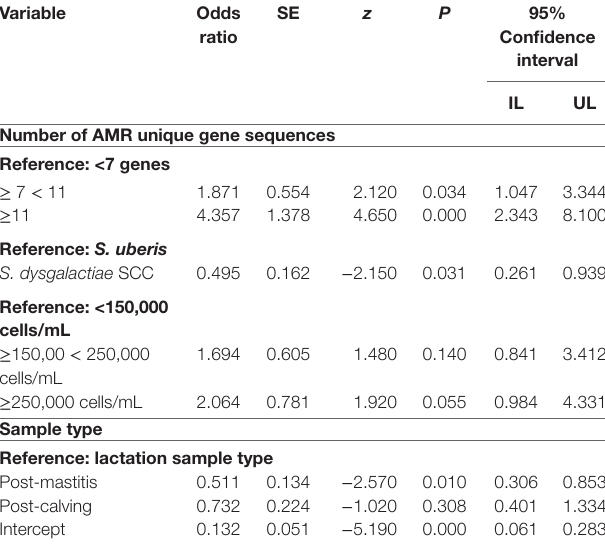
TaBle 4 | logistic model of aMr against 8 antimicrobials for isolates of Streptococcus uberis ( n = 56) and Streptococcus dysgalactiae ( n = 17) recovered from dairy cows on 17 farms in the Maritime provinces of canada (2007 and 2008) adjusted by genomic characteristics, antibiotic tested, and aMr gene